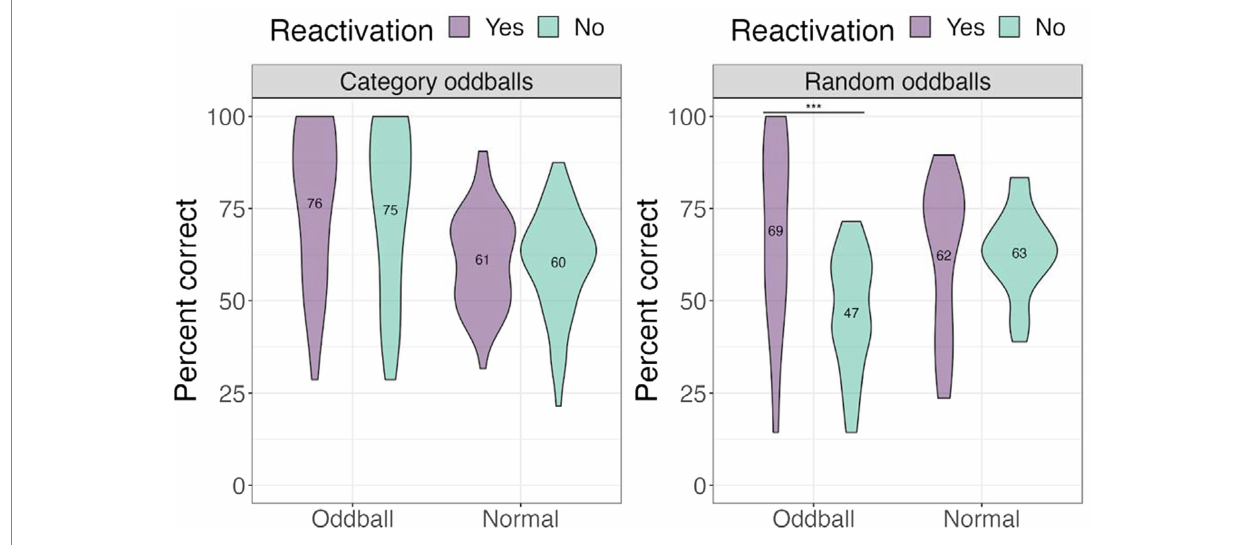
FIGURE 6 Percent correct for the location test for different oddball conditions in Experiment 1. ***The significance of p < 0.001.